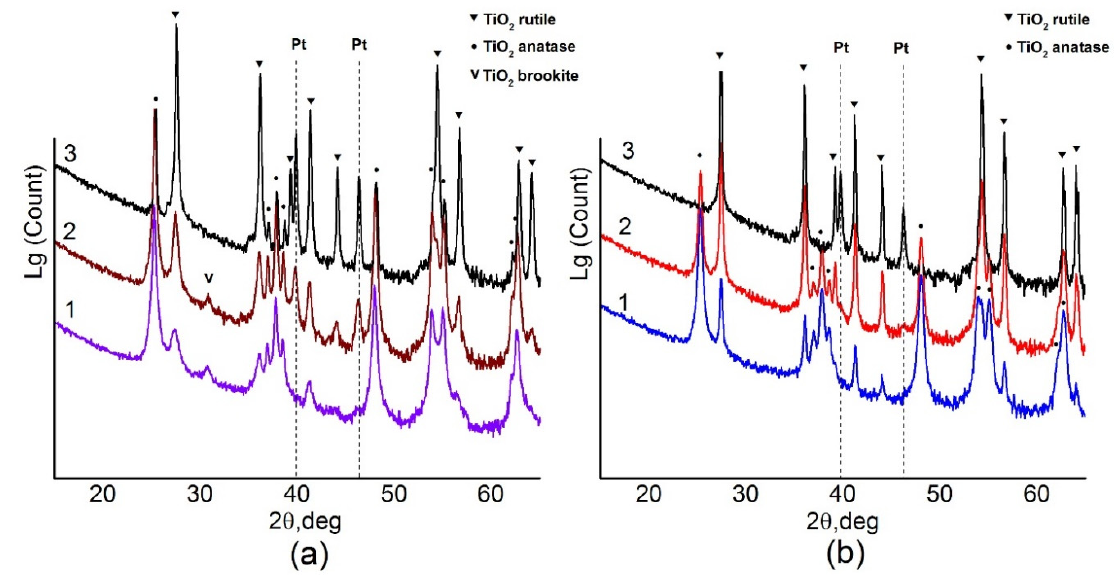
Figure 1. ( a ) X-ray di ff raction (XRD) data for Pt / Ti-PLA-400 (1), Pt / Ti-PLA -600 (2) and Pt / Ti-PLA -800 (3); ( b ) XRD data for catalysts Pt / Ti-P25-400 (1), Pt / Ti-P25-600 (2) and Pt / Ti-P25-800 (3). Table 1. Phase composition and percentage in Pt / Ti-PLA and Pt / Ti-P25 samples by XRD data.